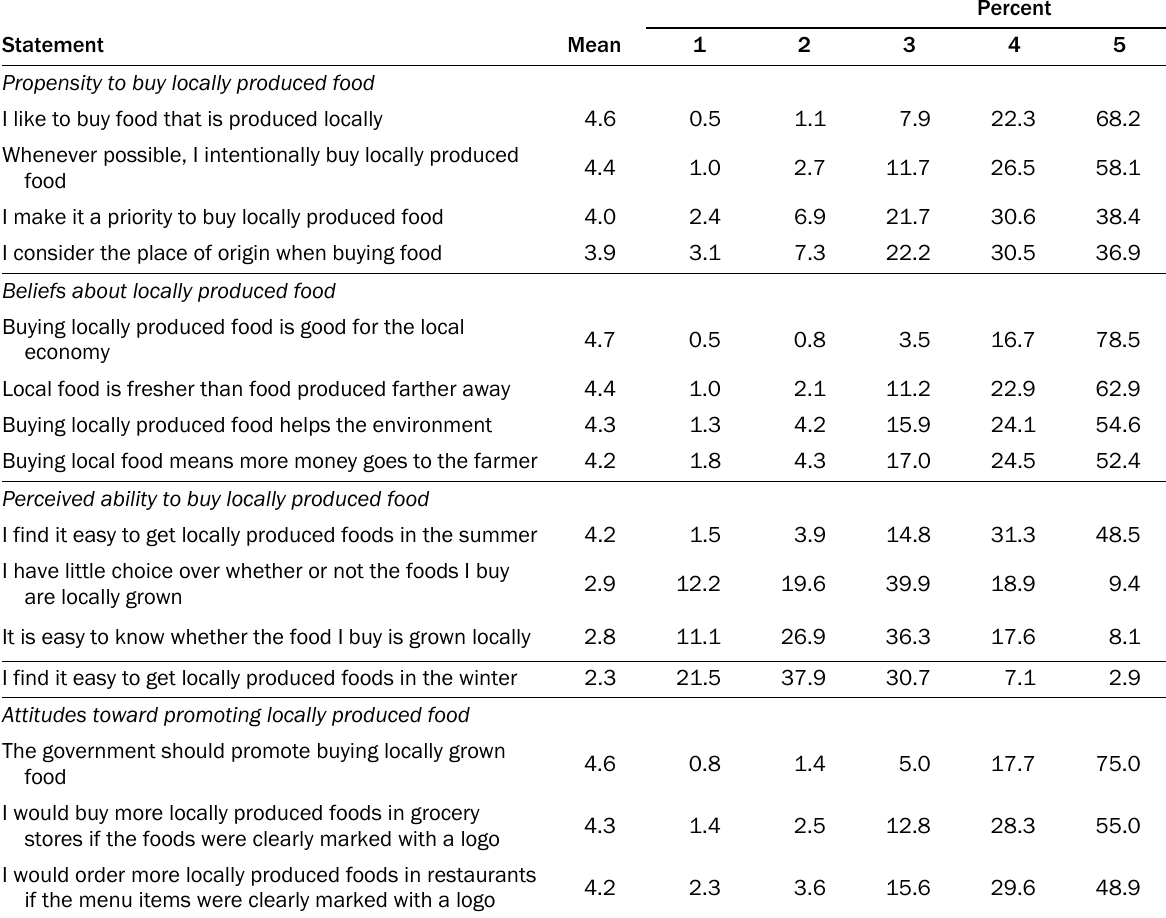
Table 5. Beliefs, Attitudes, and Propensity Toward Buying Locally Produced Food, by